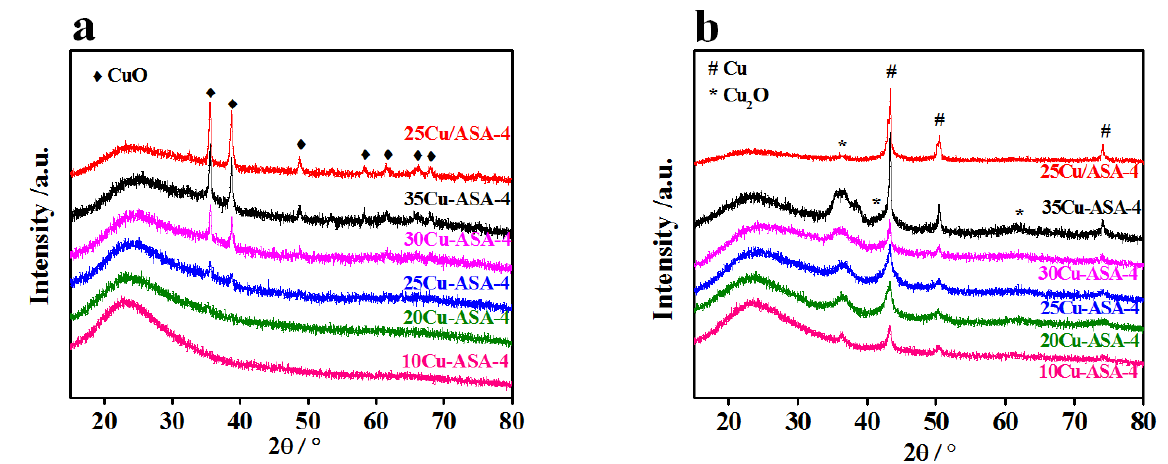
Figure 1. XRD patterns of the calcined ( a ) and reduced ( b ) xCu–ASA-4 and 25Cu/ASA-4 catalysts